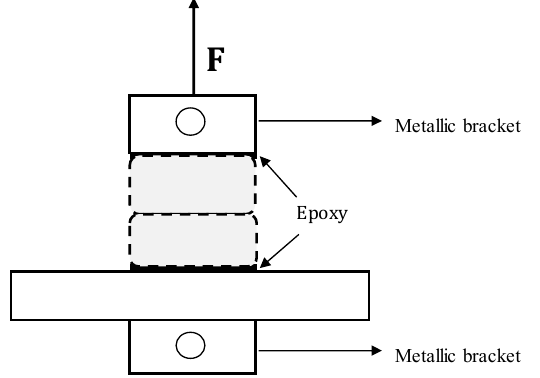
Figure 5. Schematic representation of the inter‐layer bond sample